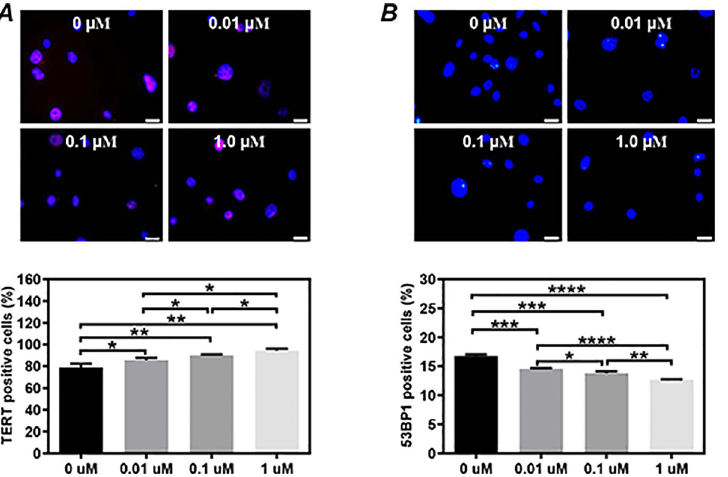
Fig 5. Dose dependency of the 17 β -estradiol supplement on the telomerase activity and DNA damage in cardiac stem cells (CSCs) from healthy female mice. The telomerase activity and DNA damage in CSCs were evaluated by immunostaining analysis on the expression of TERT (A) and 53BP1 (B) , respectively, after 3 days of culture with the supplement of different concentrations of 17 β -estradiol in the medium. Representative images (upper) and quantitative data (lower) are shown. The nuclei were labeled with DAPI. Scale bar: 20 μ m. Control: sham-operated mice, Ovx: ovariectomized mice, LE 2 : ovariectomized mice received a low dose of 17 β -estradiol (0.01 mg/60 days), HE 2 : ovariectomized mice received a high dose of 17 β -estradiol (0.18 mg/60 days). All data are mean ± SD from 3 independent experiments (n = 3 for each group). � P < 0.05, �� P < 0.01, ��� P < 0.001, ���� P < 0.0001.